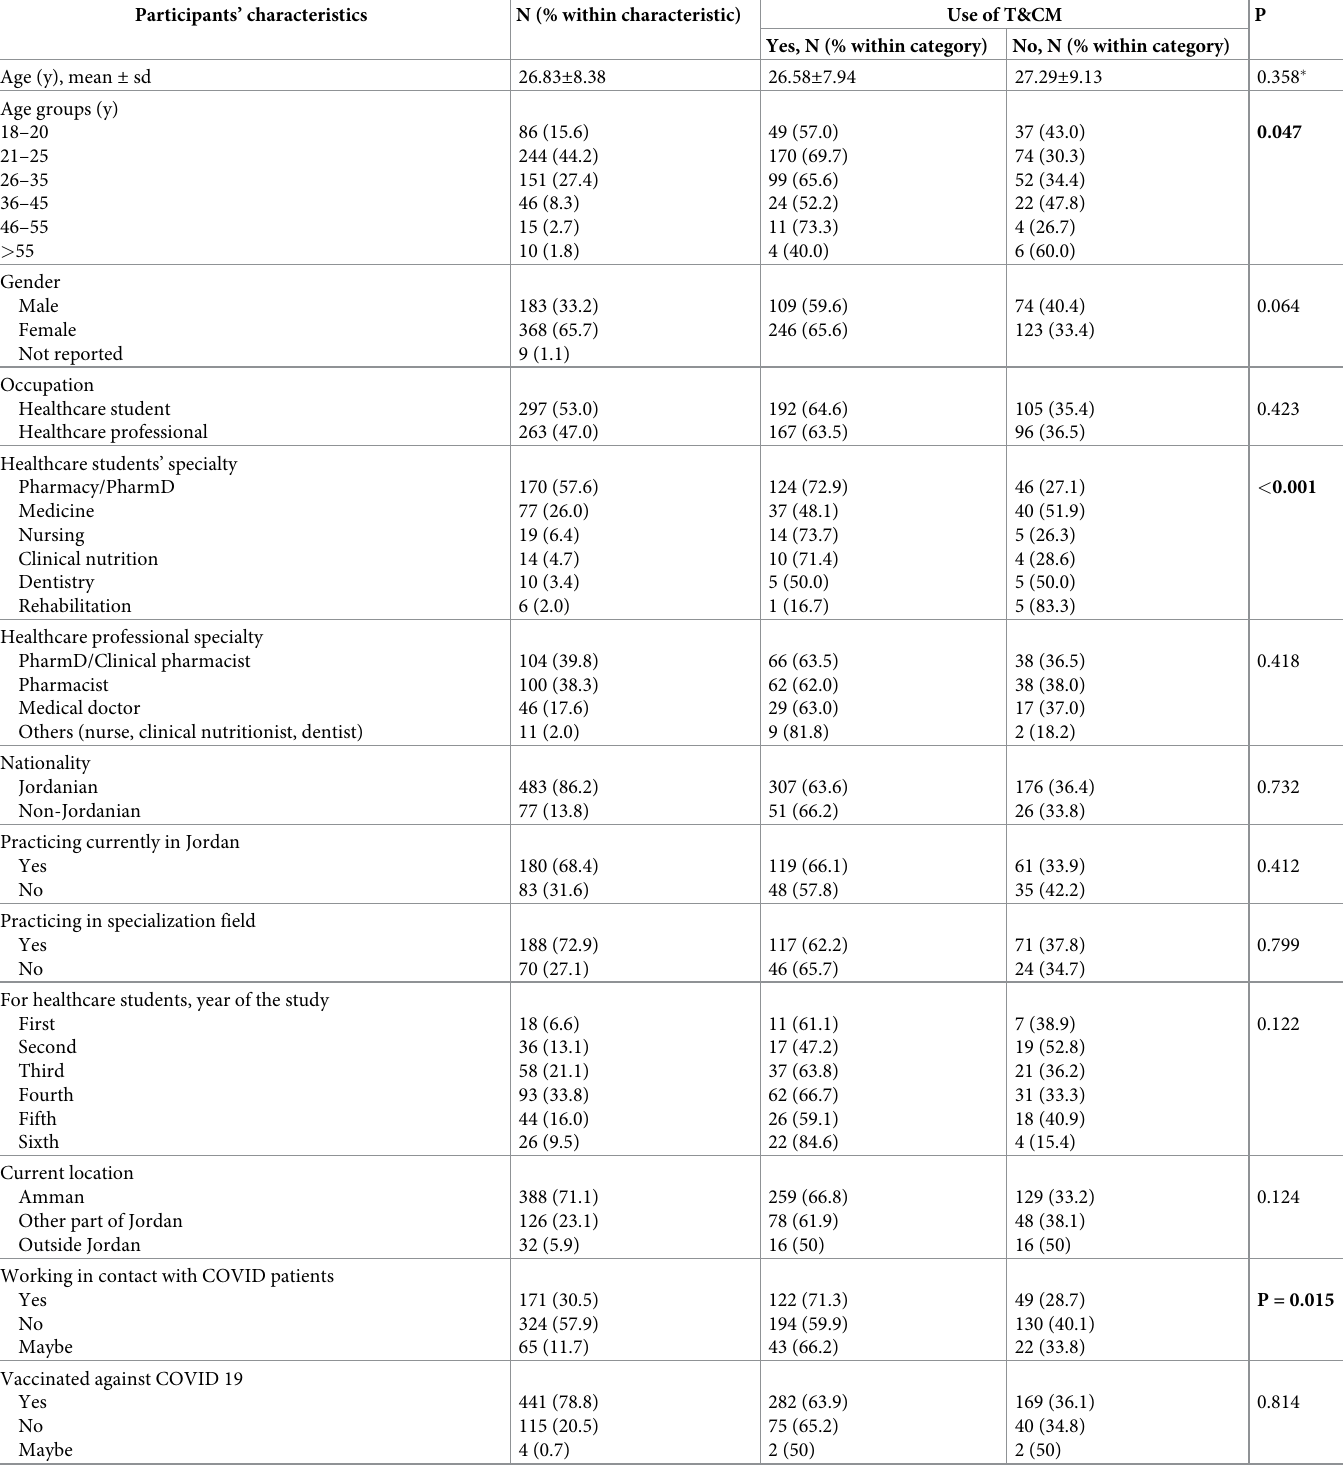
Table 1. Demographic and professional characteristics of study participants and their association with T&CM use (N = 560). Participants’